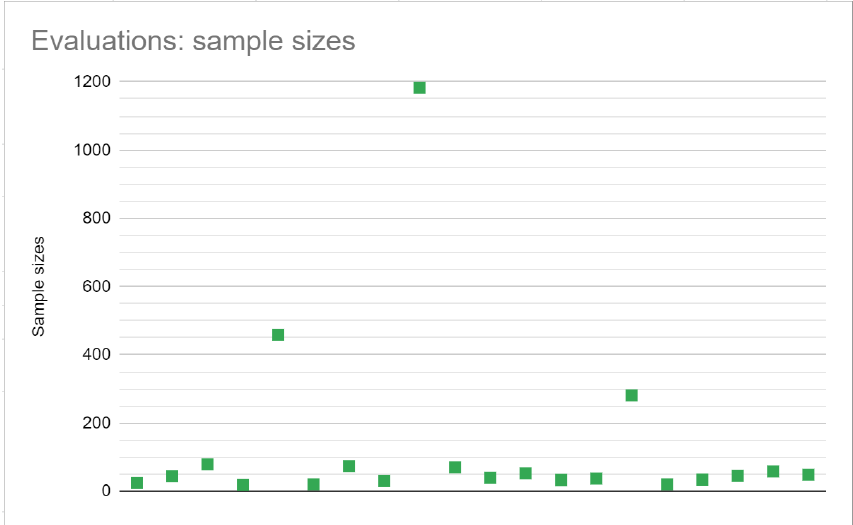
Figure 4. Sample sizes of the conducted evaluations for immersion-related